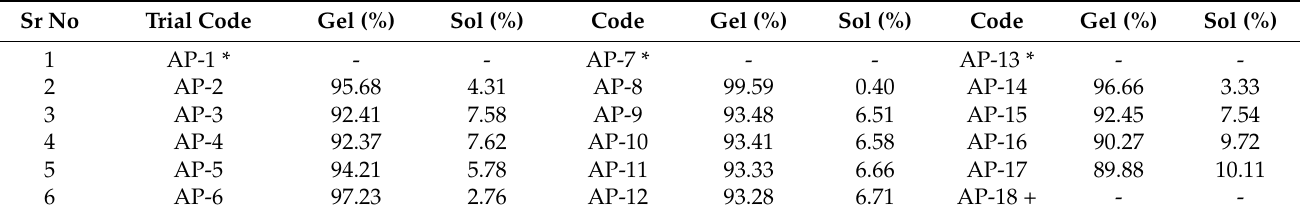
Table 2. Sol-gel fraction of semi-IPN hydrogel matrices ( n =